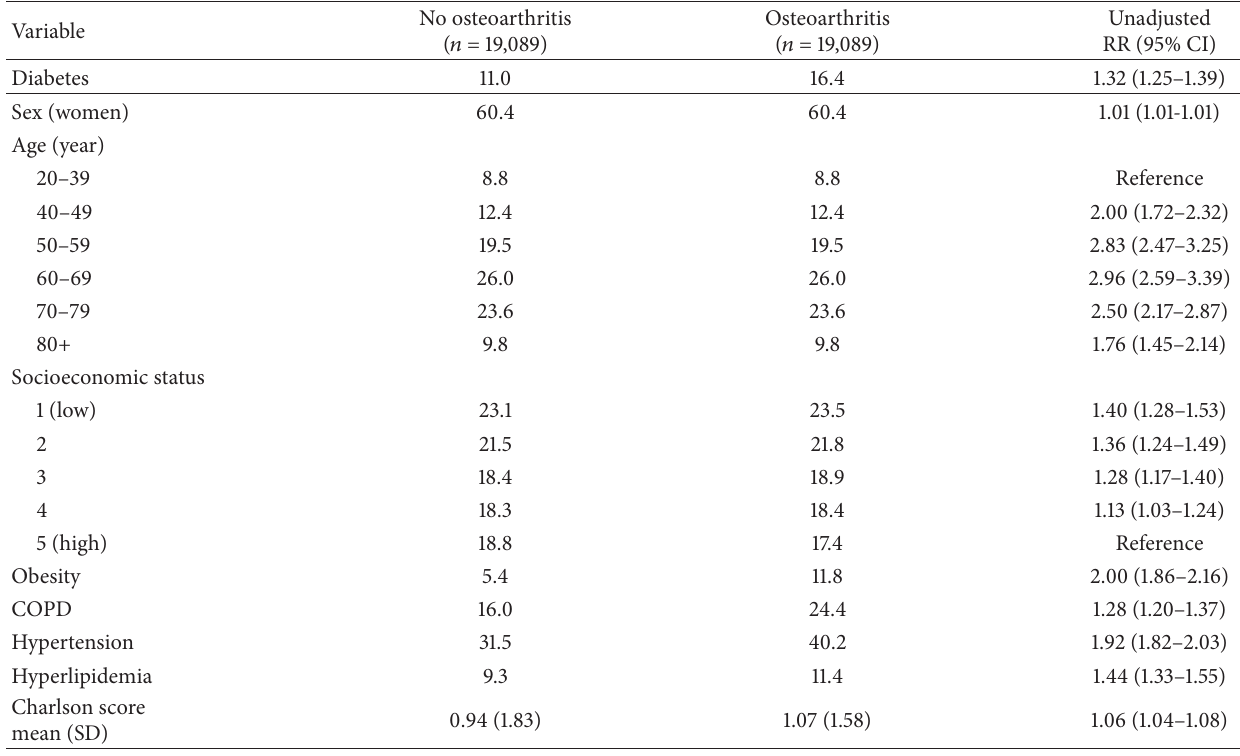
Table1:Distributionofvariablesbyexposure(osteoarthritis)statusandunadjustedrelativerisks(RRs)ofdiabetesobservedintheprospective analysis.